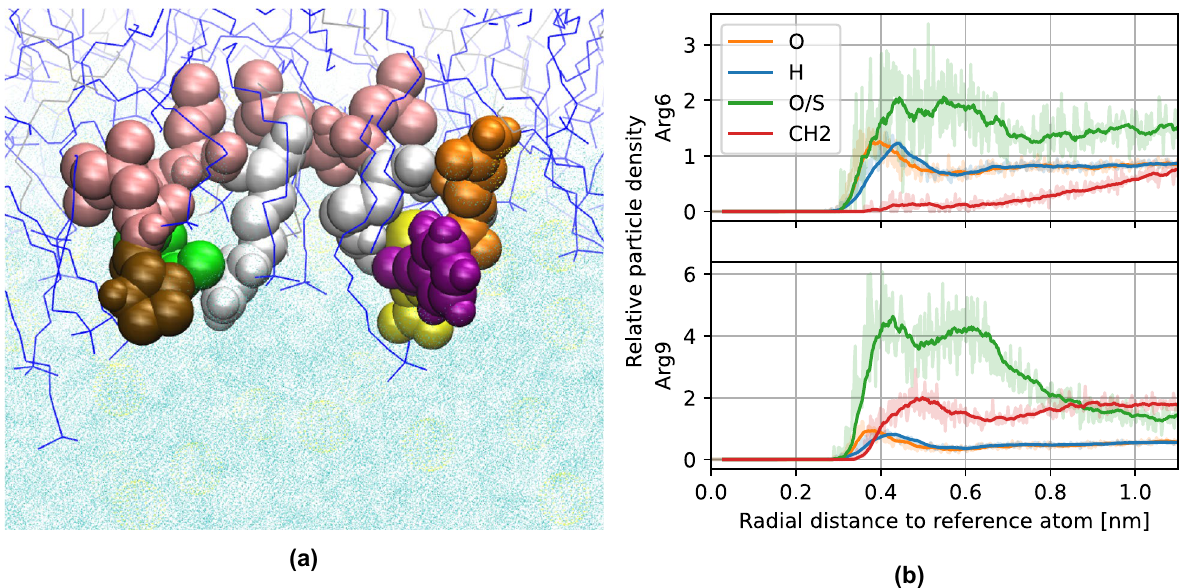
Figure 9. ( a ) Single frame of the TP1 peptide at the second step of the potential stair , 1.67 nm away from the bilayer center. ( b ) Radial distribution functions of arginine fragments of the